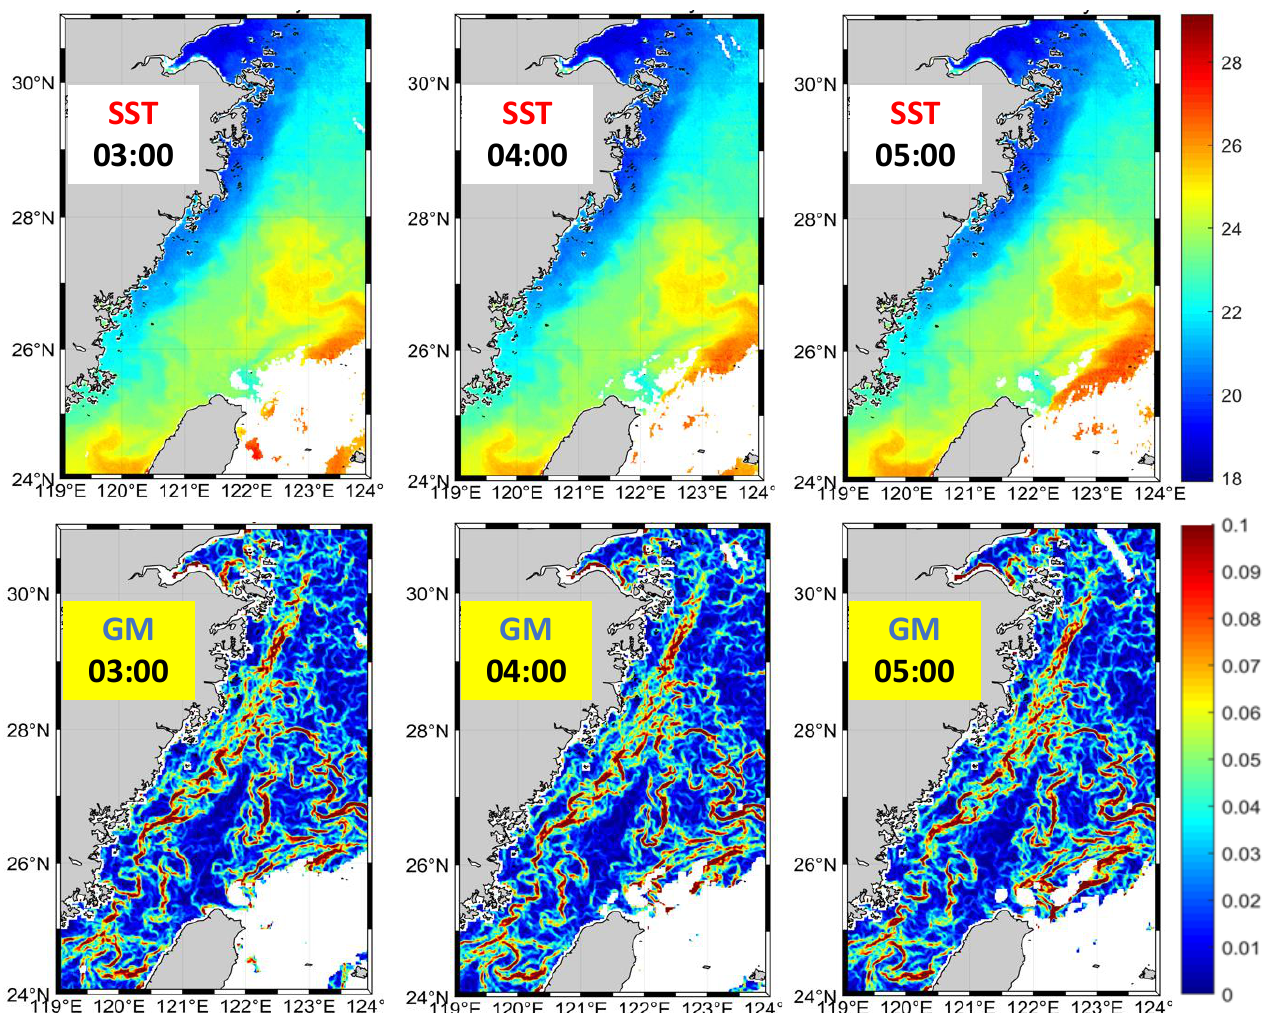
Figure 1. Sample hourly data from 27 October 2018. Top row, SST (°C); bottom row, SST gradient magnitude GM (°C/km). In order to show fine (submesoscale) fronts, the GM color scale is cut off at 0.1 °C/km; peak values of GM at some grid points could be much higher (up to 0.4 °C/km). Offshore fronts do not change their location, shape, and gradient at the hourly scale, while many inshore shallow fronts vary appreciably over hourly intervals.